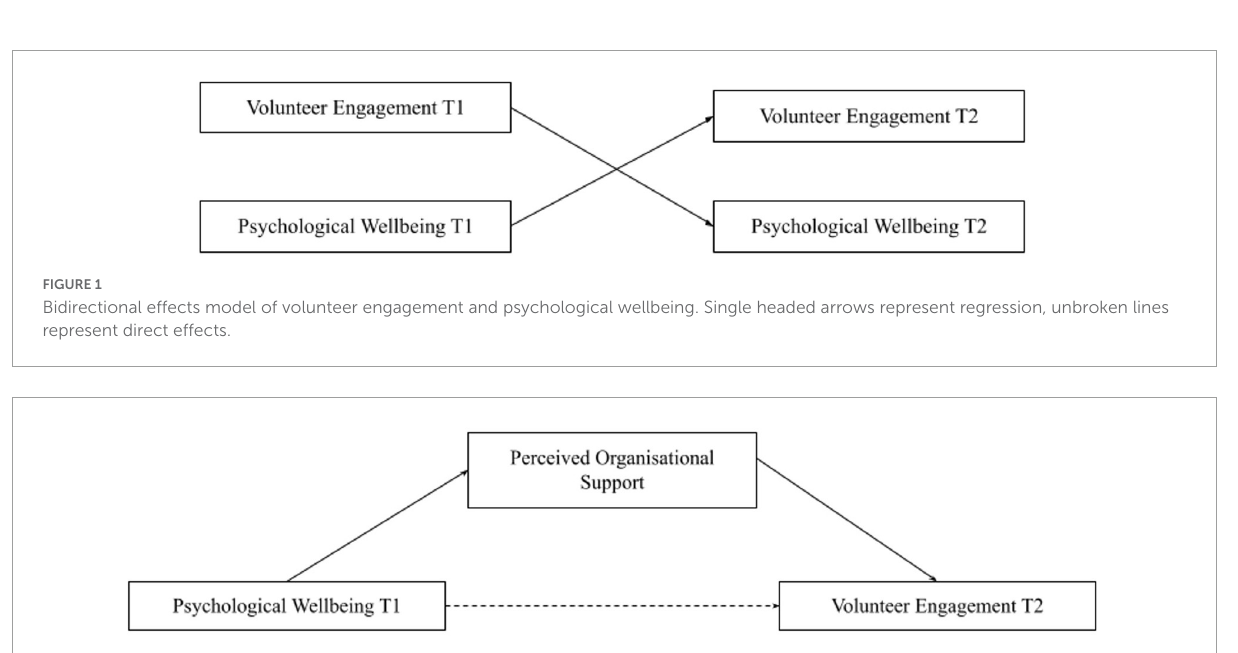
FIGURE2 Mediation model of perceived organizational support mediating psychological wellbeing Tl and volunteer engagement T2. Single headed arrows represent regression, unbroken lines represent direct effects, broken lines represent indirect